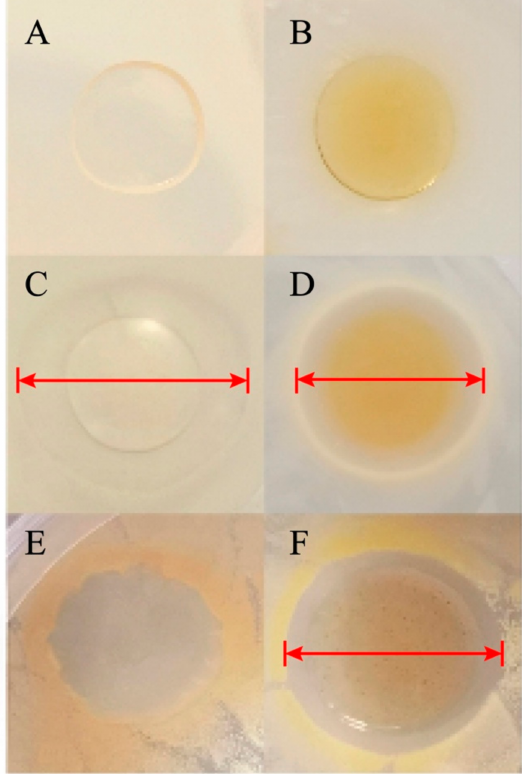
Figure 5. Antibacterial activity of films against Escherichia coli and Staphylococcus aureus in co- culturation mode: ( A ) KGM (KGM 1%) film ( E. coli ), ( B ) KGM/SL (KGM 1%, SL 0.2%) film ( E. coli ), ( C ) KGM/ ε -PL (KGM 1%, ε -PL 0.375%) film ( E. coli ), ( D ) KGM/SL/ ε -PL (KGM 1%, SL 0.2%, ε -PL 0.375%) film ( E. coli ), ( E ) KGM (KGM 1%) film ( Staphylococcus aureus ), ( F ) KGM/SL/ ε -PL (KGM 1%, SL 0.2%, ε -PL 0.375%) film ( Staphylococcus aureus